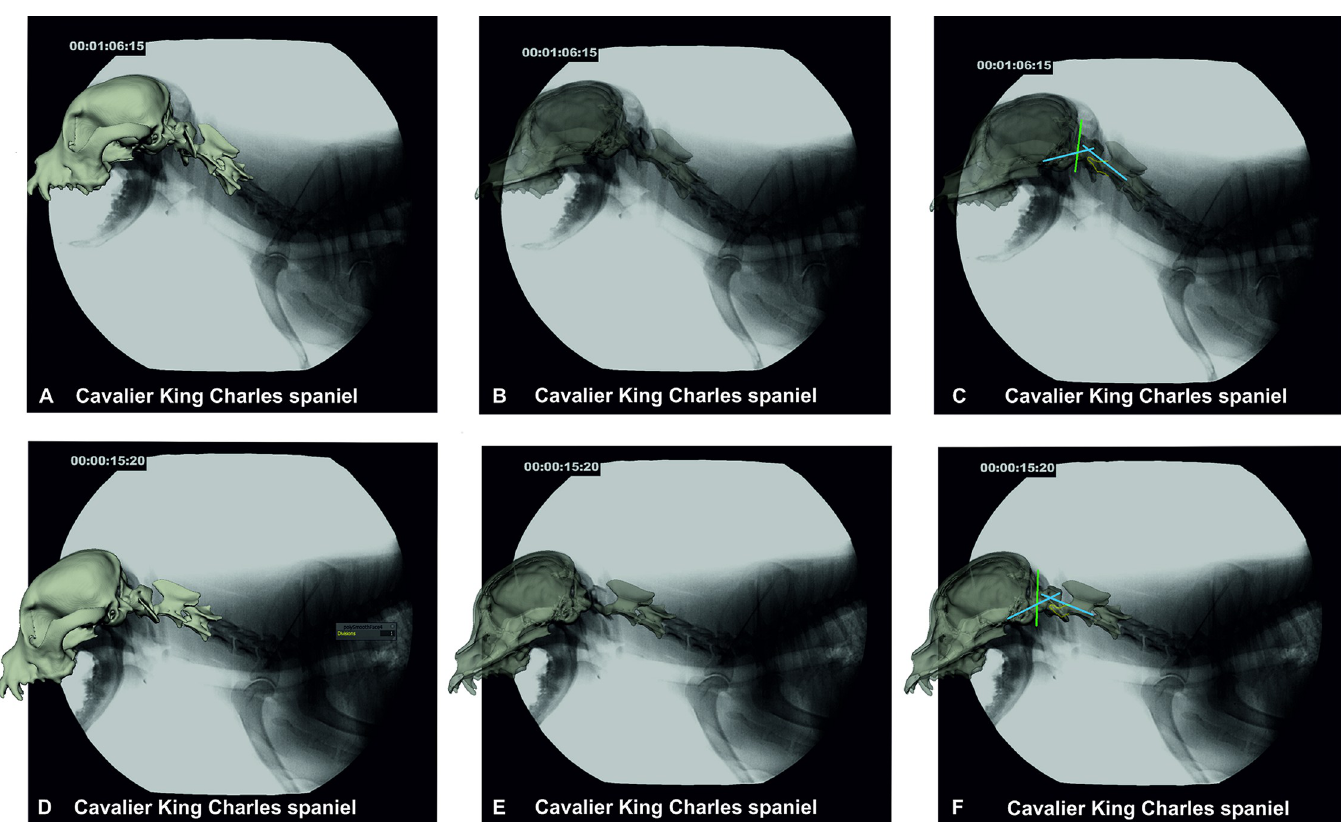
Fig 8. CCJ position in a walking CKCS. Images A–C: CKCS 2 in walk with an elevated neck position. Images D–F: CKCS 2 in walk with a lowered neck position. A/D: fluoroscopy image with superimposed bone model, B/E: semi-transparent bone model and transparent atlas, C/F: semi-transparent bone model and illustration of the (modified) McRae’s line (green line). Wackenheim’s clivus baseline (rostral blue line) and clivus canal angle (both blue lines, angle in image C 127˚, image F: 131˚). The contour of the dens is highlighted in yellow. 90˚ camera position.